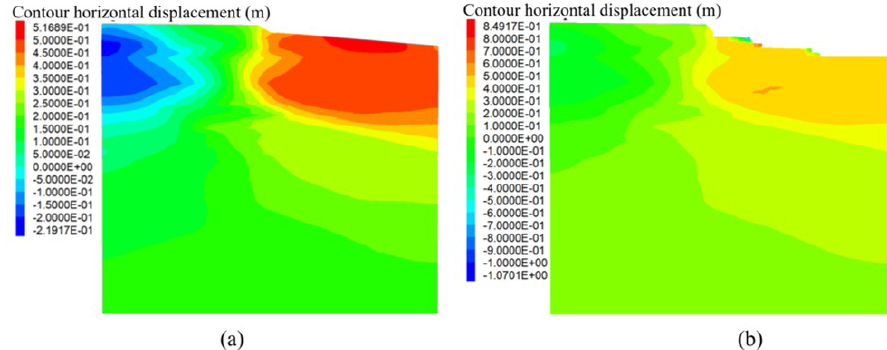
Figure 35. Horizontal displacement contours in metres (a) after seismic loading and (b) after tsunami loading.